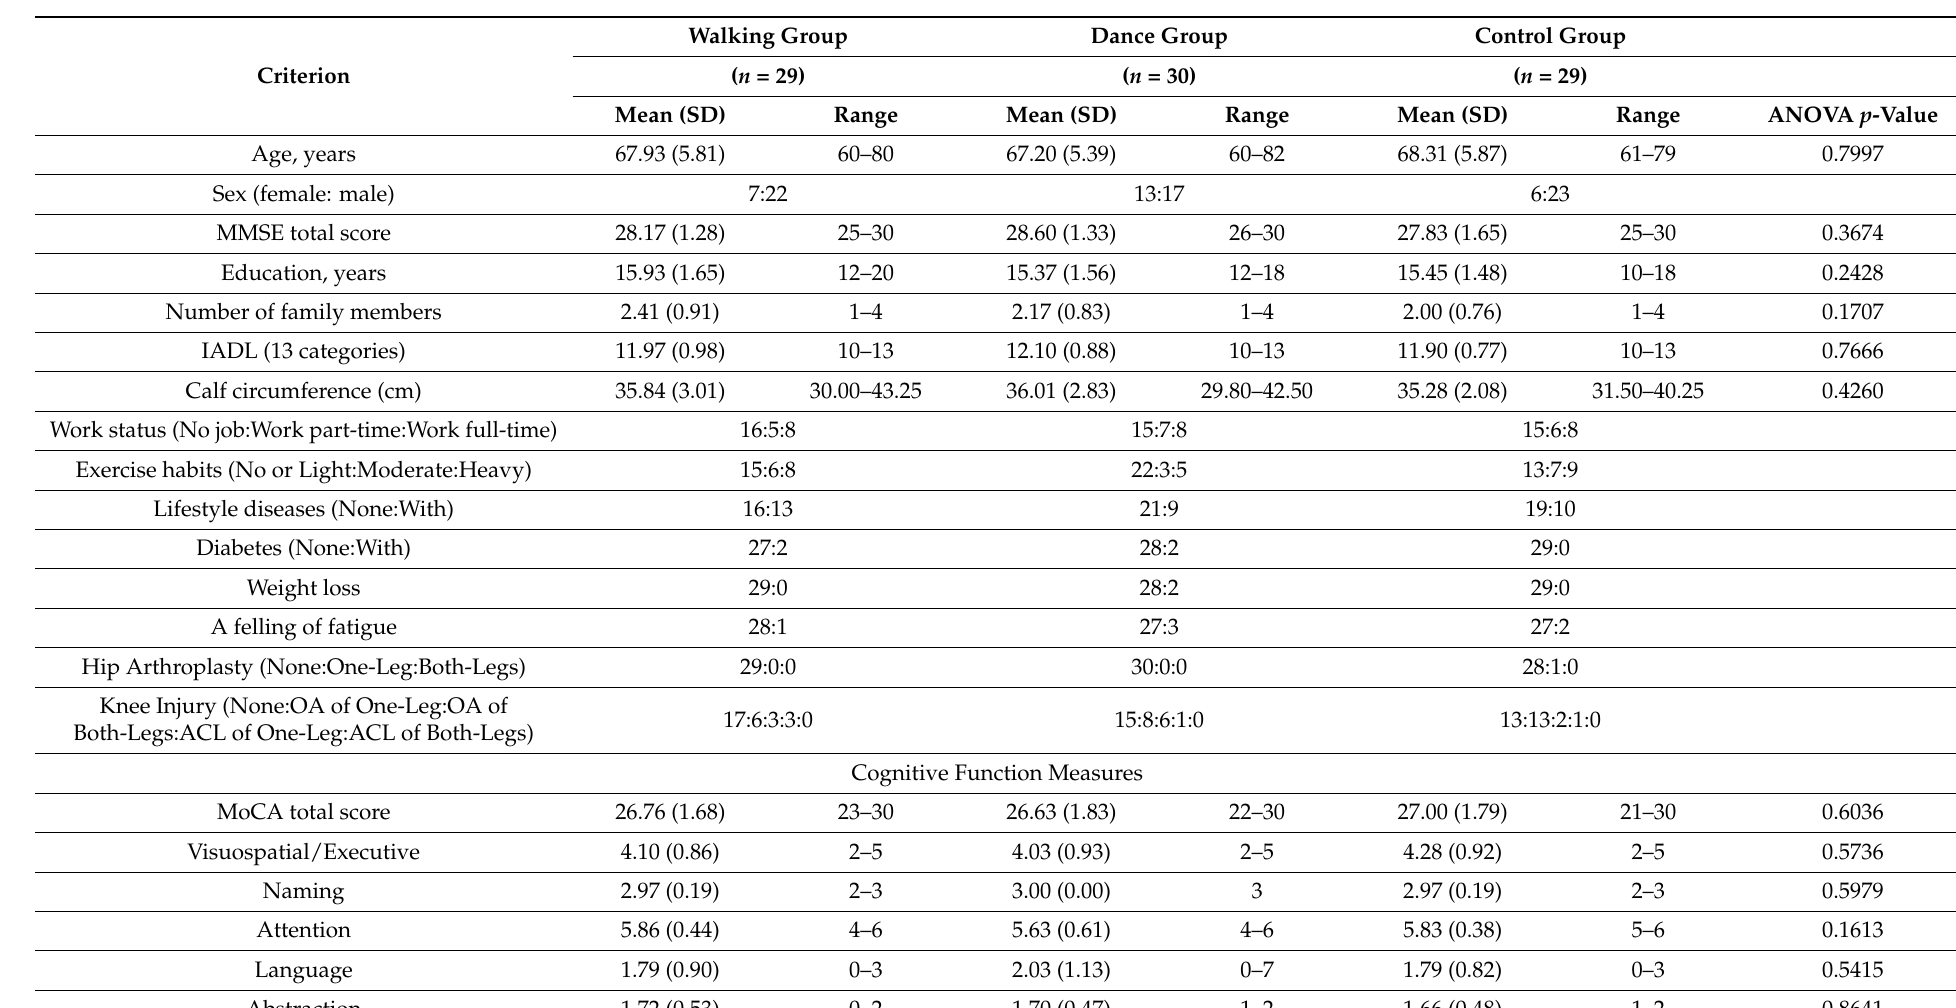
Table 1. The participant characteristics at